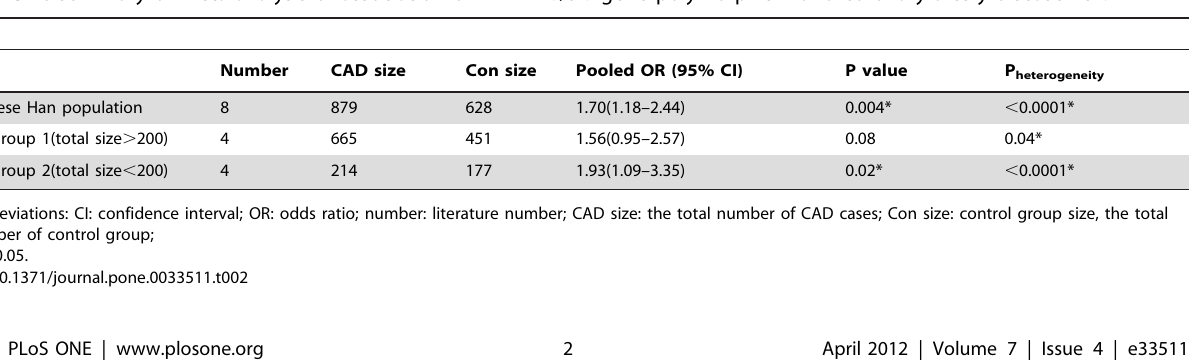
Table 2. Summary of meta-analysis of association of PAI-1 4G/5G gene polymorphism and coronary artery disease